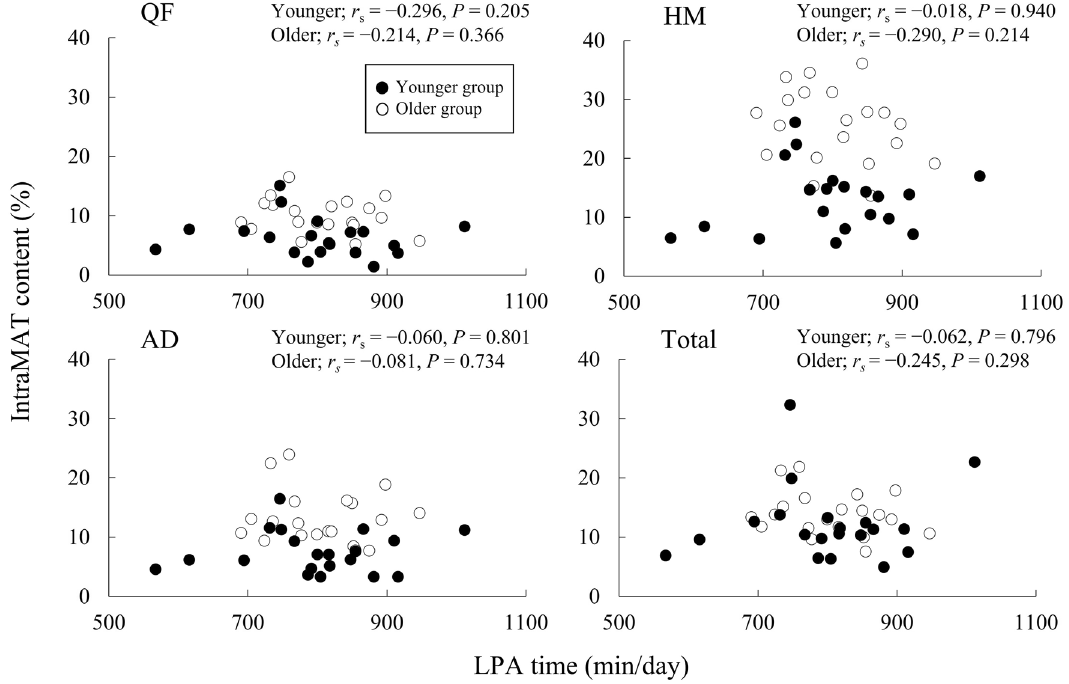
Figure 1. Correlation between light-intensity physical activity (LPA) time and intramuscular adipose tissue (IntraMAT) content in younger and older men. QF quadriceps femoris, AD hip adductors, and HM